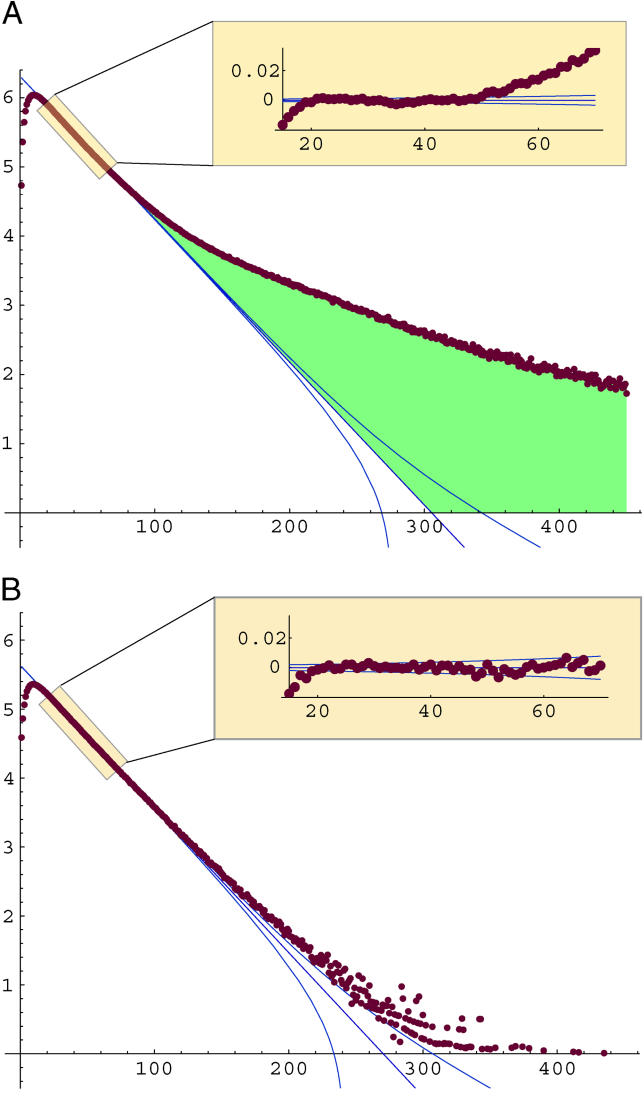
Genomic Distribution of Intergap DistancesHistogram of intergap distance counts (log10 scale) in human–mouse alignments, (A) within the whole genome and (B) within ARs. Blue lines indicate predictions of the neutral model (central line, geometric distribution; the slope is related to the per-site indel probability ρ), and expected sampling errors (outer curves; 95% confidence intervals for a binomial distribution per length bin). Insets show a blow-up of the deviation from the model (log10 scale). Parameters were obtained by linear regression to the log-counts, weighted by the expected binomial sampling error. The indel distribution on AR data shows an excellent model fit, in particular in the range 20–80 bp, with 92% of counts (56/61) lying within 95% confidence limits. The whole-genome histogram shows a similarly tight fit in the range 20–50 bp, and a large excess of long intergap distances over neutral model predictions (green) beyond ~50 bp. The intercept of the geometric prediction occurs at a length L = 300. This implies that less than one ungapped sequence of any length L > 300 is expected genome-wide under the neutral model; however the model does predict a small but nonzero probability for any such sequence, even under neutrality.